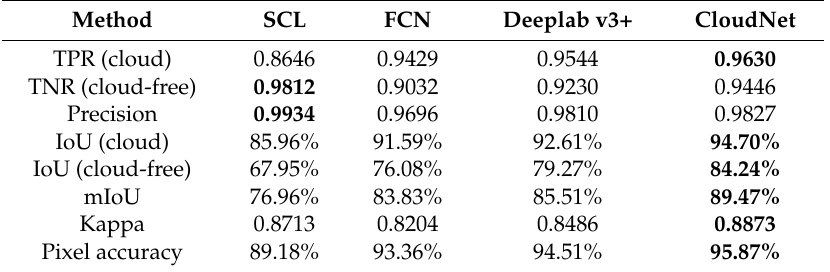
Table 1. Evaluation of various deep learning (DL) architectures in classifying clouds, using eight indicators. TPR: True positive rate; TNR: True negative rate; IoU: Intersection over union; mIoU: The average of IoU (cloud) and IoU